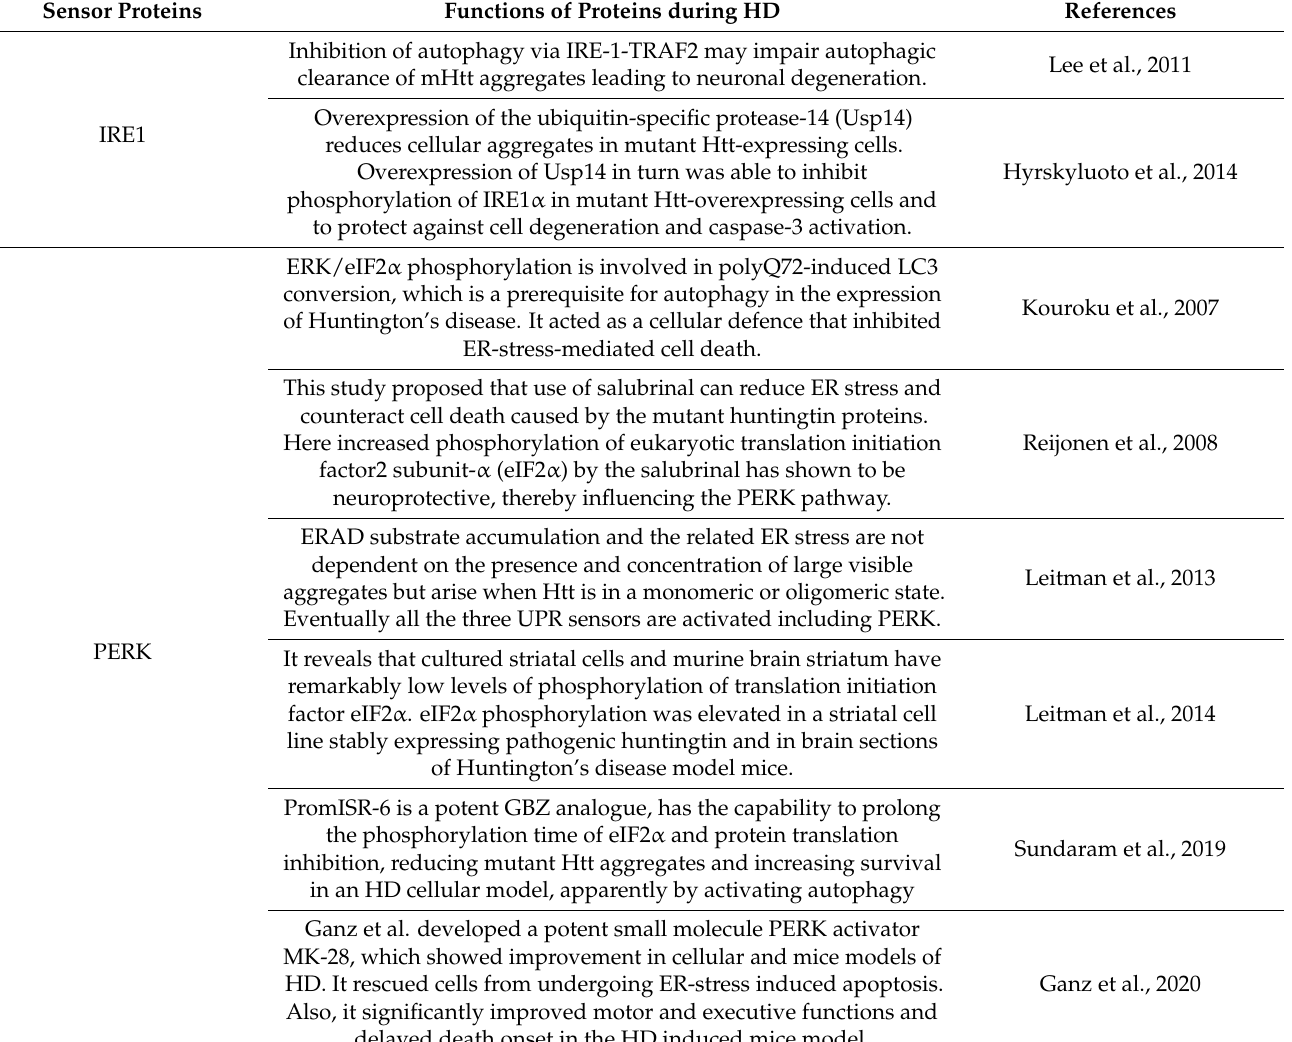
Table 1. ER stress sensors and